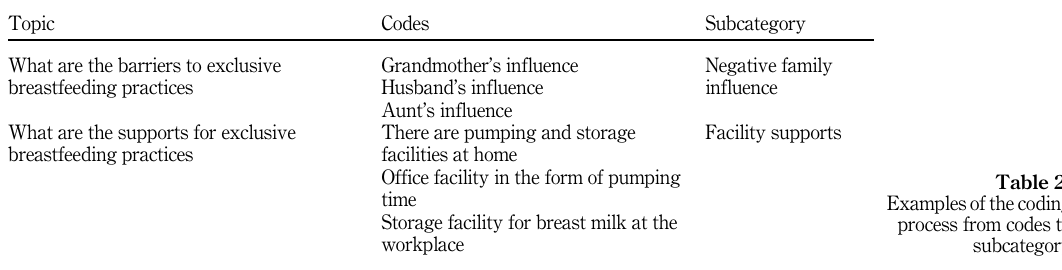
Table 1. Examplesofthecoding